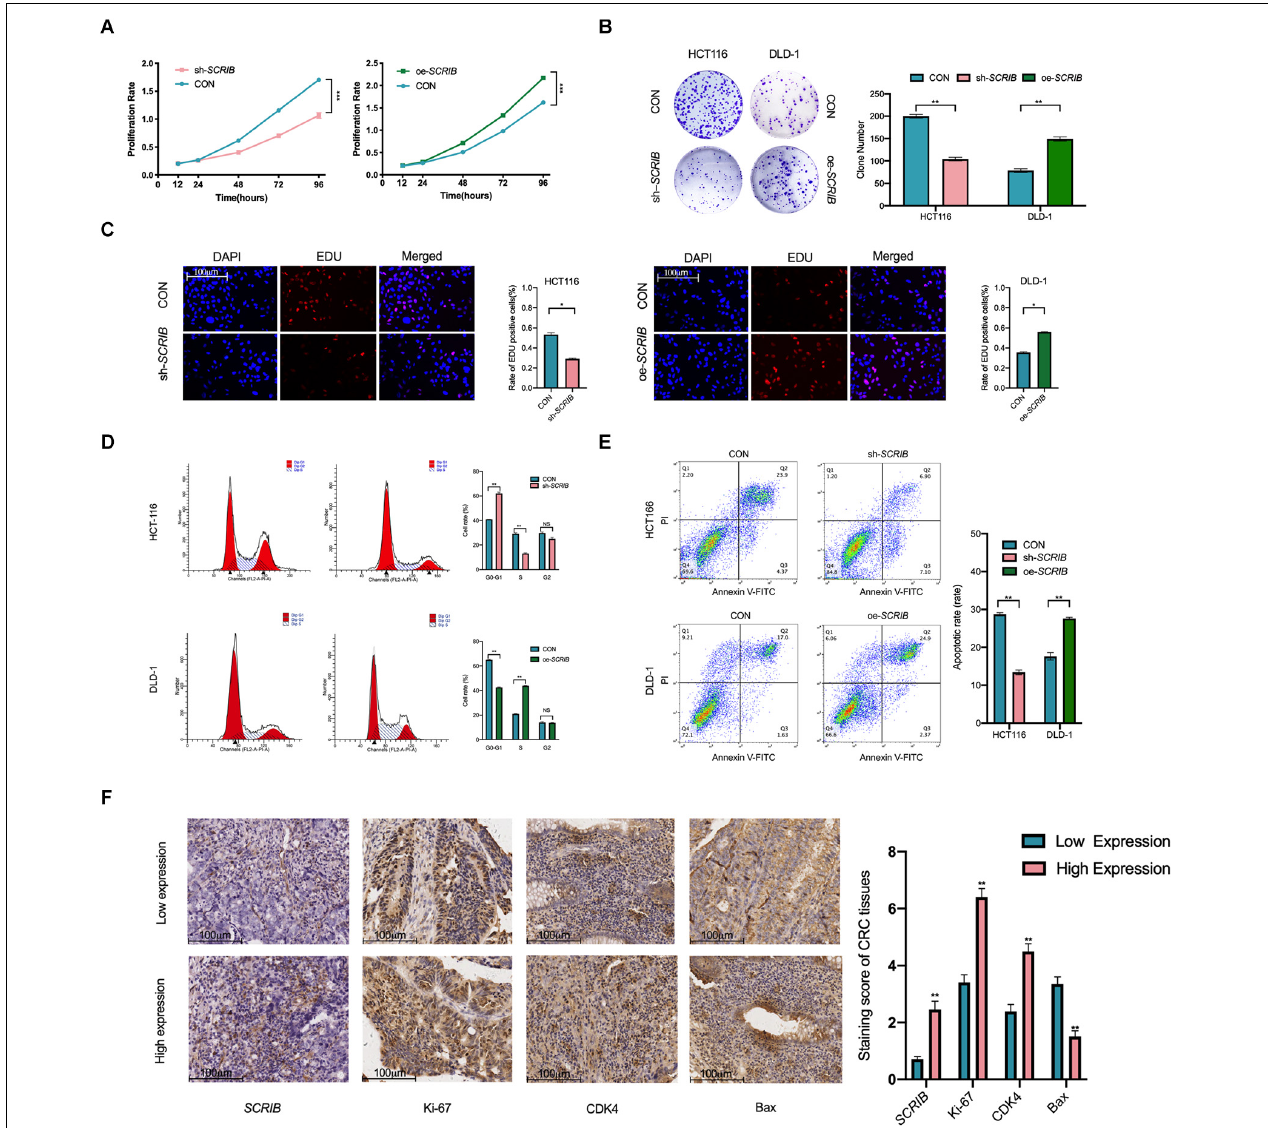
FIGURE 3 | SCRIB promotes CRC cell proliferation and inhibits apoptosis in vitro. (A) Cells were seeded in 96-well plates after transfection with oe- SCRIB and sh- SCRIB and the corresponding empty vectors, and the cell number was assessed on days 1–4 using CCK-8 assays. The knockdown of SCRIB suppressed the proliferation of HCT116 cells, whereas the overexpression of SCRIB promoted the proliferation of DLD-1 cells. (B) Effect of overexpression or knockdown of SCRIB on the colony formation ability of CRC cells; representative graphs are shown. (C) EdU immunofluorescence staining confirmed the function of SCRIB in the proliferation of CRC cells, scale bars: 100 µ m. (D) Flow cytometry showing significant increases or decreases in the proportion of HCT116 cells in the G1 or S phase, respectively, when SCRIB was knocked down. In the SCRIB -overexpressing DLD-1 cells, the number of cells in the G1 or S phase decreased or increased, respectively. (E) The apoptotic rates (LR + UR) of transfected cells were detected by flow cytometry (Q2 + Q3). LR, early apoptotic cells; UR, terminal apoptotic cells. (F) Immunohistochemical staining of Ki-67, CDK4 and Bax was performed, and their expression was compared between SCRIB high-expressing CRC tissues and SCRIB low-expressing tissues, scale bars: 100 µ m. The data are shown as the mean ± SD of three independent experiments, * P < 0.05, ** P < 0.01, and *** P < 0 .